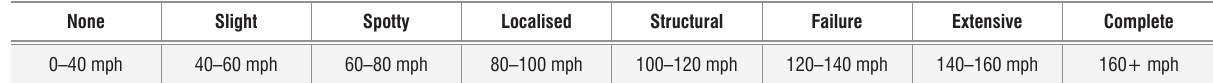
The Karen Clark and Co. Wind Damage Scale None Slight Spotty Localised Structural Failure Extensive